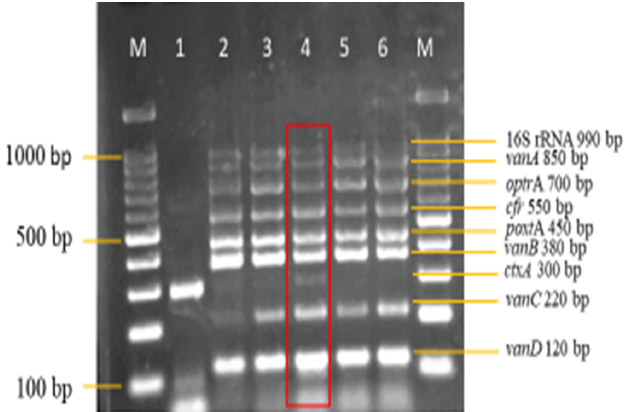
Figure 4. dNTPs concentration optimization in the multiplex PCR. A concentration of 0.16 mM on lane 4 from a range of concentrations (0.08–0.24 mM) was selected as the optimum concentration. Lane M: DNA ladder 100 bp plus. Lane 1: Negative control with ctxA (Internal control). Lane 2: 0.08 mM of dNTPs. Lane 3: 0.12 mM of dNTPs. Lane 4: 0.16 mM of dNTPs. Lane 5: 0.20 mM of dNTPs. Lane 6: 0.24 mM of dNTPs.